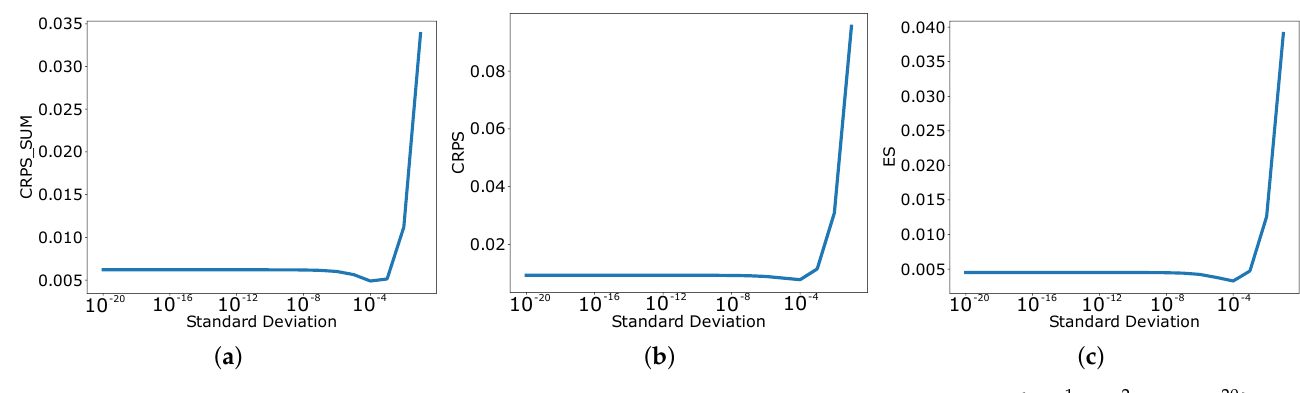
Figure A3. The assessment of multivariate dummy model with σ ∈ { 10 − 1 ,10 − 2 , . . . ,10 − 20 } using CRPS-Sum, CRPS and ES. The plot is depicted on logarithmic scale. ( a ) CRPS-Sum. ( b ) CRPS. ( c )